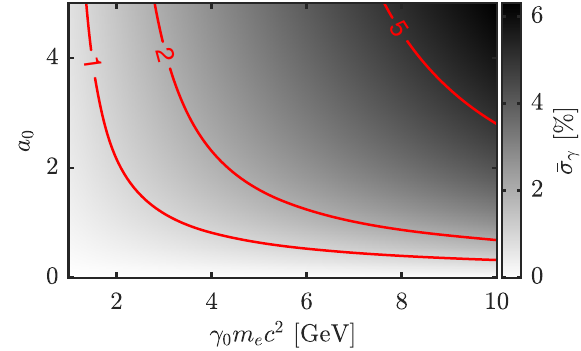
FIG. 5. Relative energy spread increase due to ICS at 90° for c 2 . The Gaussian laser pulse varying a 0 and electron energy γ m e had a wavelength of 800 nm, τ ¼ 50 fs and infinite transverse extent. The red isolines give the combination of electron energy FIG. 6. Interaction geometry of electron beam (purple) trailing and a 0 which results in the given percentage increase in energy a laser pulse (blue). The laser pulse after reflection (red) from the planar surface interacts with the electron spread.